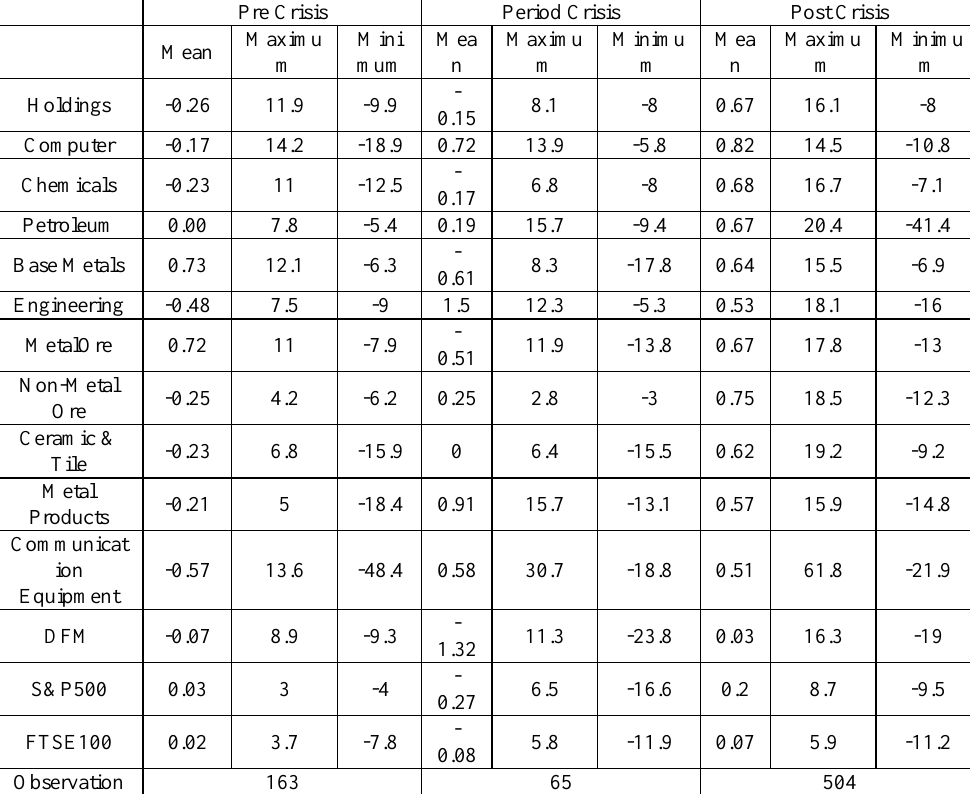
Table 4-3. Markets Descriptive